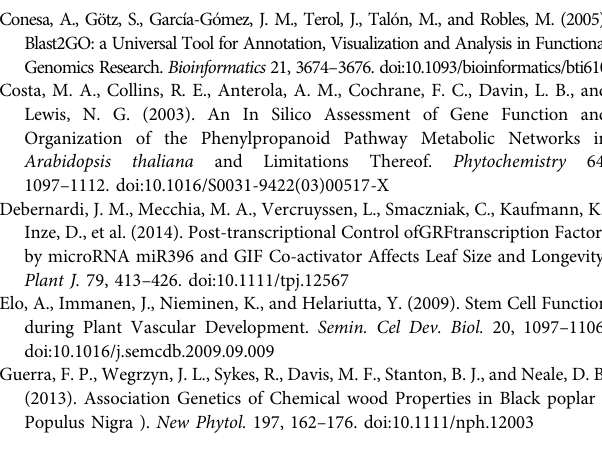
Supplementary Figure 2 | GO enrichment of lncRNA colocation target genes in nine comparative combinations. Supplementary Figure 3 | Expression pro fi le of lncRNAs and mRNAs related to photosynthesis in different tissues. Supplementary Figure 4 | GO (A) and KEGG (B) analyses of co-location and co- expression mRNAs. BP, biological process; MF, molecular function; CC, cellular component. Supplementary Figure 5 | Expression patterns of lncRNAs (A) and mRNAs (B) related to lignin and fl avonoid biosynthesis. Supplementary Figure 6 | lncRNA and mRNA results from RNA-seq veri fi ed by qRT-PCR. Mean ± SD from three biological replicates. Supplementary Table 1 | Primer pairs for qRT- PCR. Supplementary Table 2 | RNA-seq fi lter data. Supplementary Table 3 | Basic information of lncRNAs was identi fi ed in P . deltoides “ Danhong ” and P . simonii “ Tongliao1. ” Supplementary Table 4 | Co-location target mRNAs of lncRNAs. Supplementary Table 5 | Co-expression mRNAs of